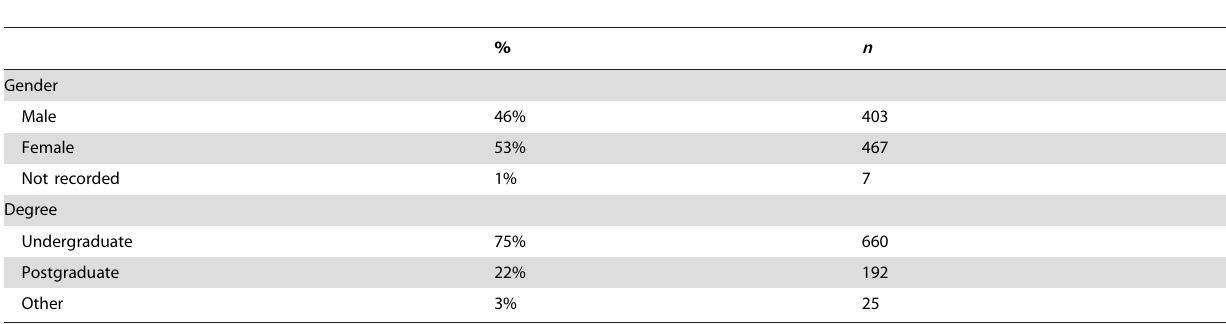
Table 1. Participant characteristics ( n =877).